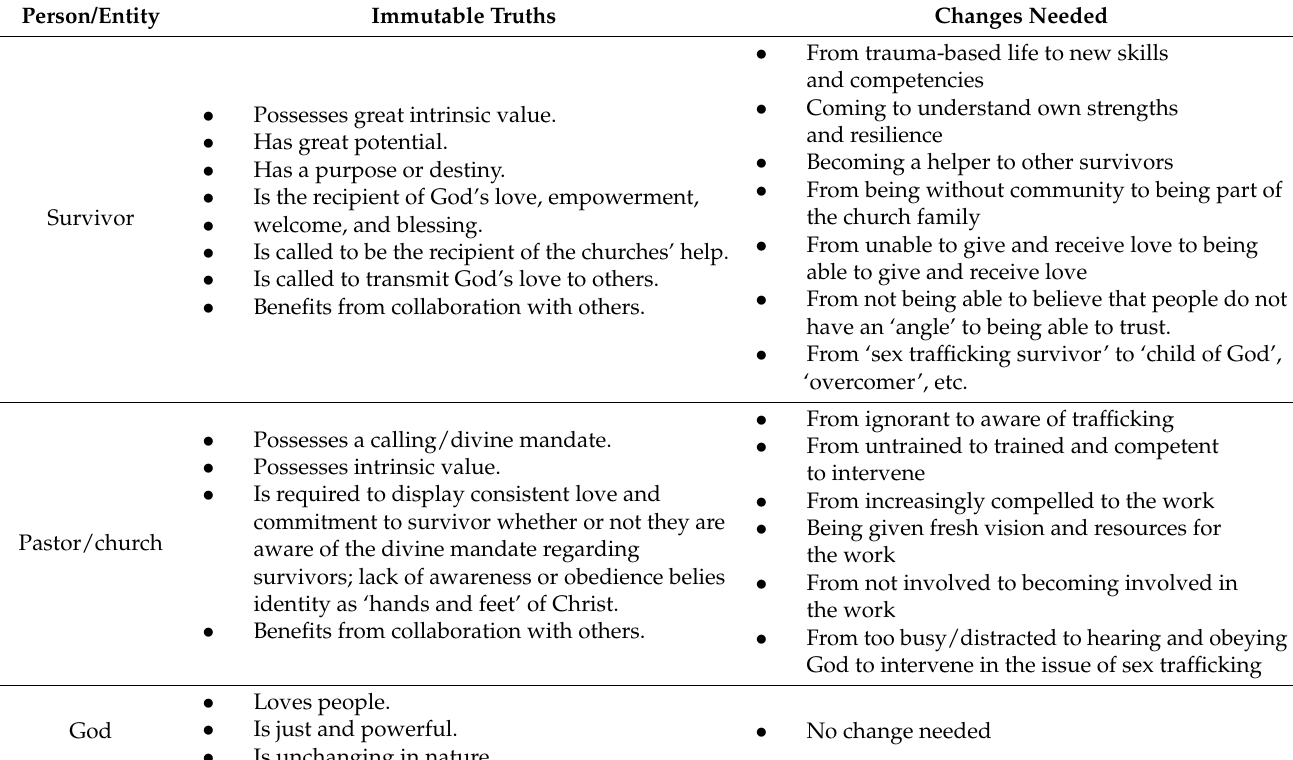
Table 2. Prominent Truths and Changes Needed in Participants’